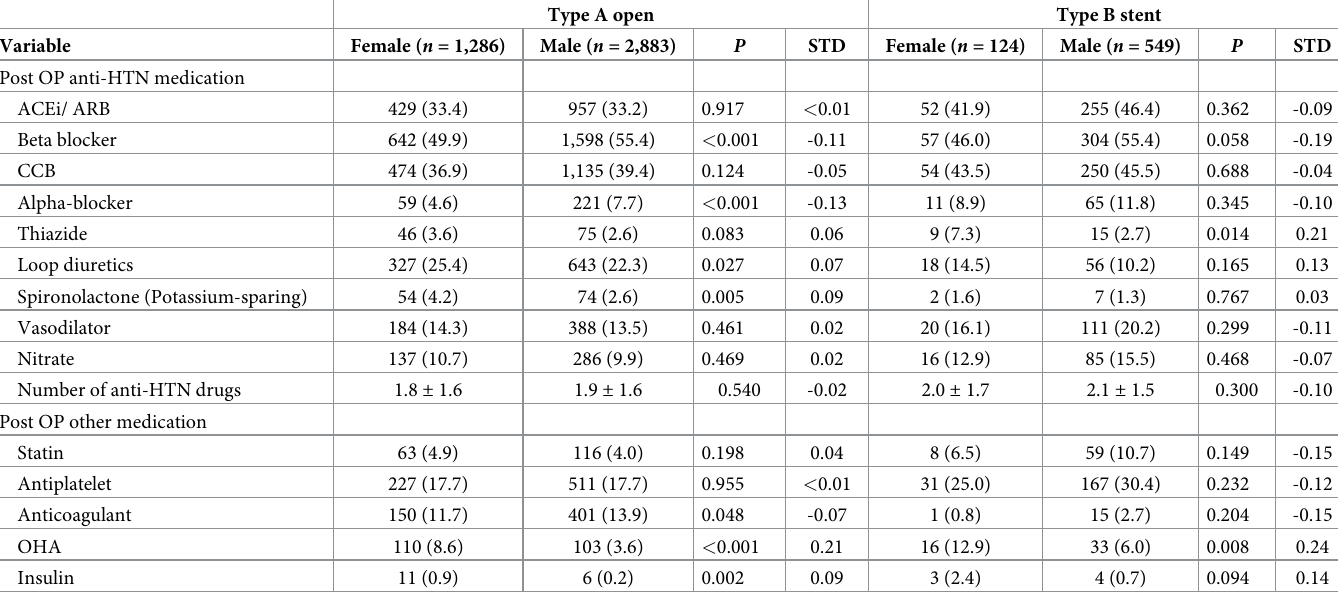
Table 3. Medication use of the female and male patients who received AAD surgery before propensity score matching.